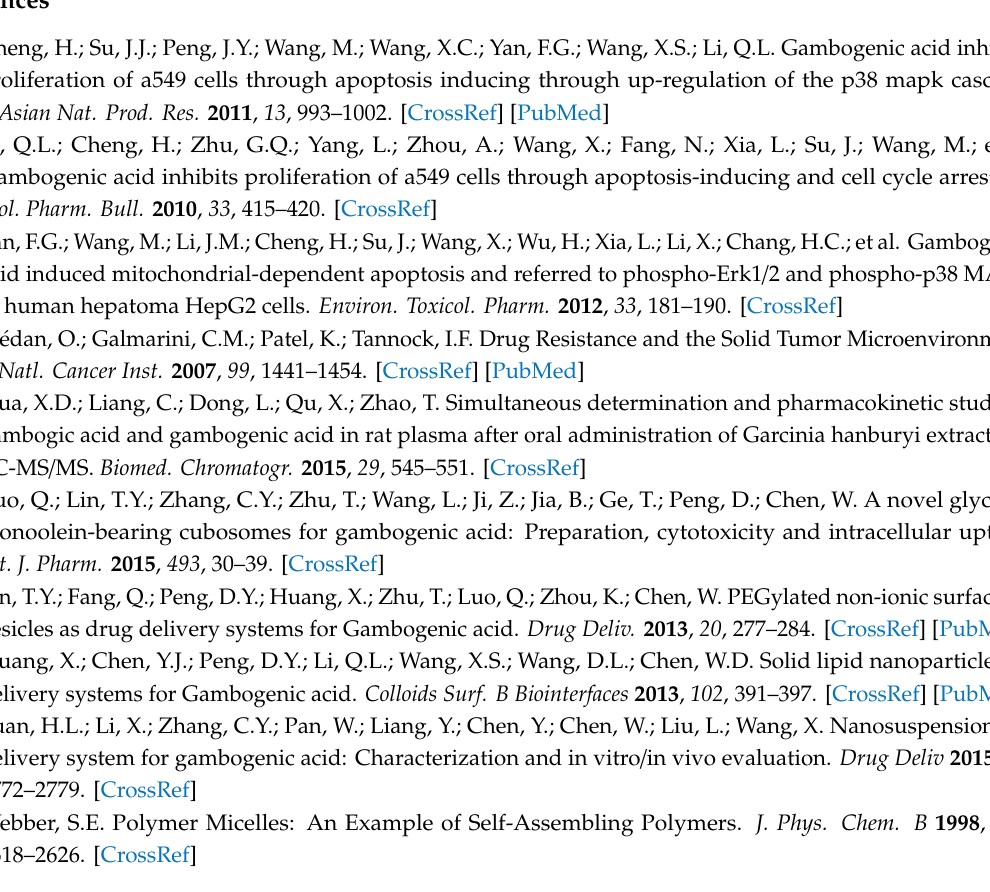
Figure S1: 1 H NMR spectrum of P t BA in CDCl 3 ( δ solvent = 7.26 ppm), Figure S2: GPC traces of P t BA (a) and P t BA- b -PCL (b), Figure S3: IR spectra of PAA- b -PCL (a) and P t BA- b -PCL